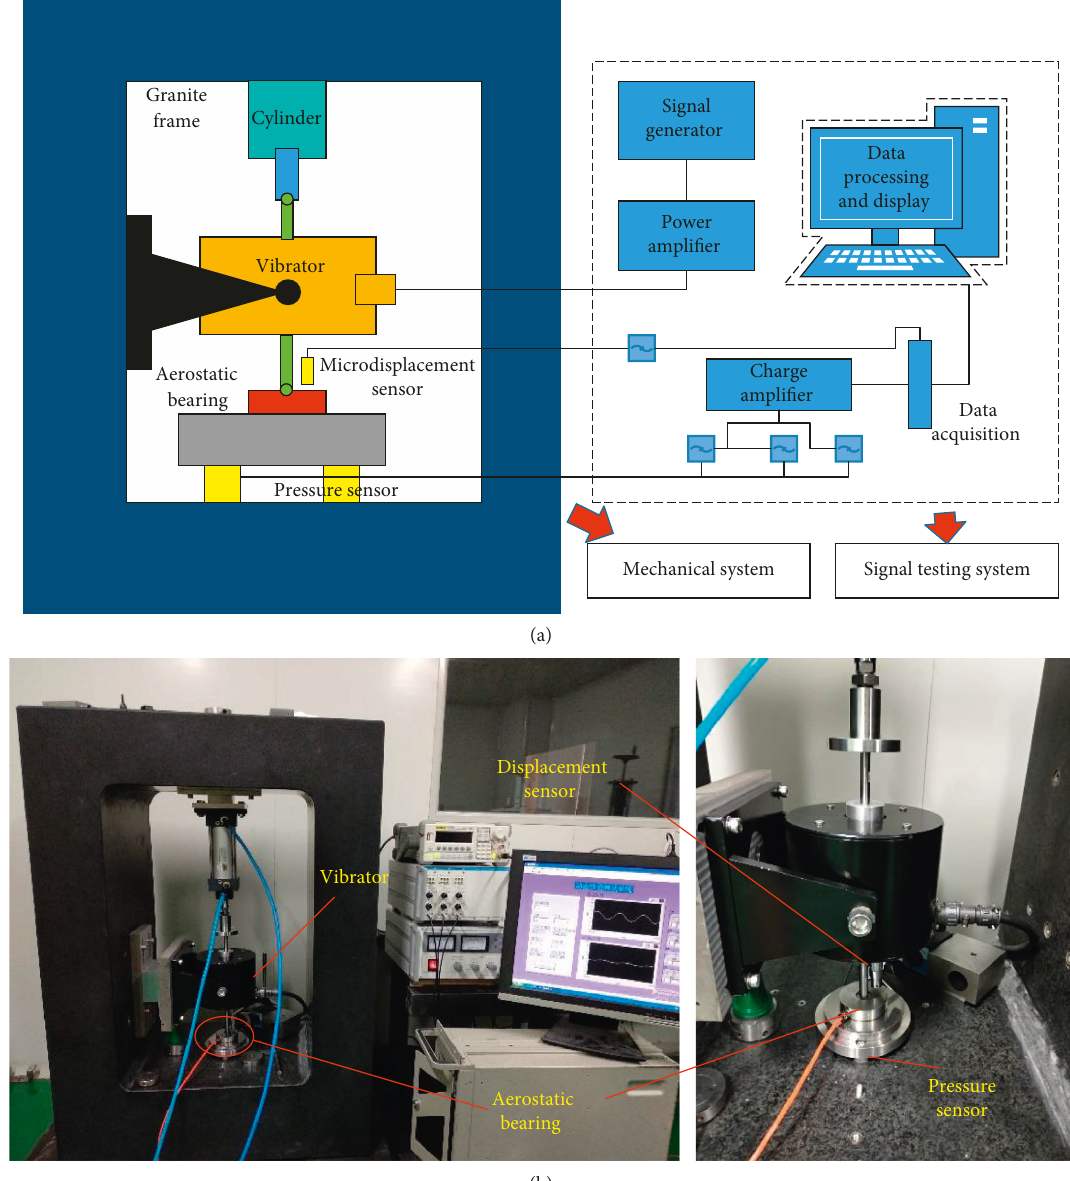
Figure 2: (a) Principle diagram of the dynamic test rig. (b) Physical map of the dynamic test